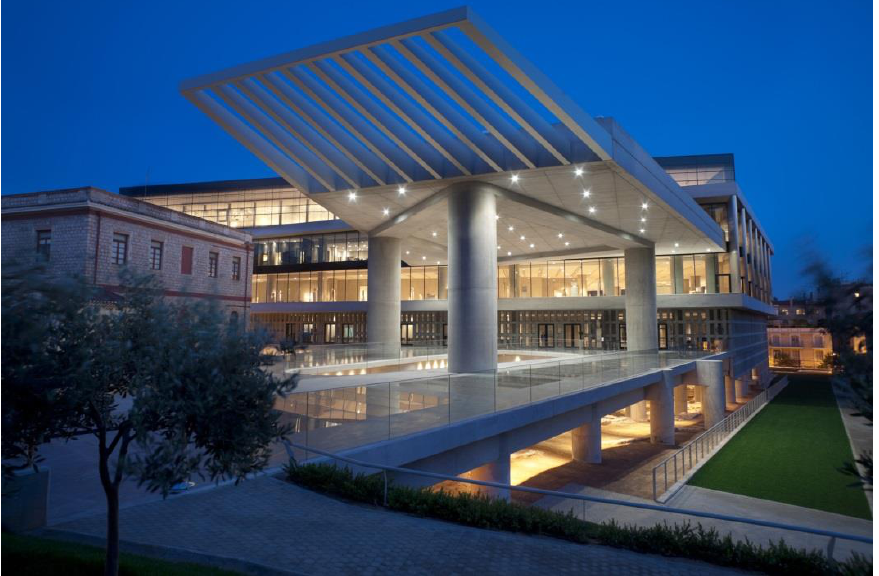
Figure 1. The north-facing forecourt and entrance of the New Acropolis Museum at night. Photograph: Nikos Danielidis. © Acropolis